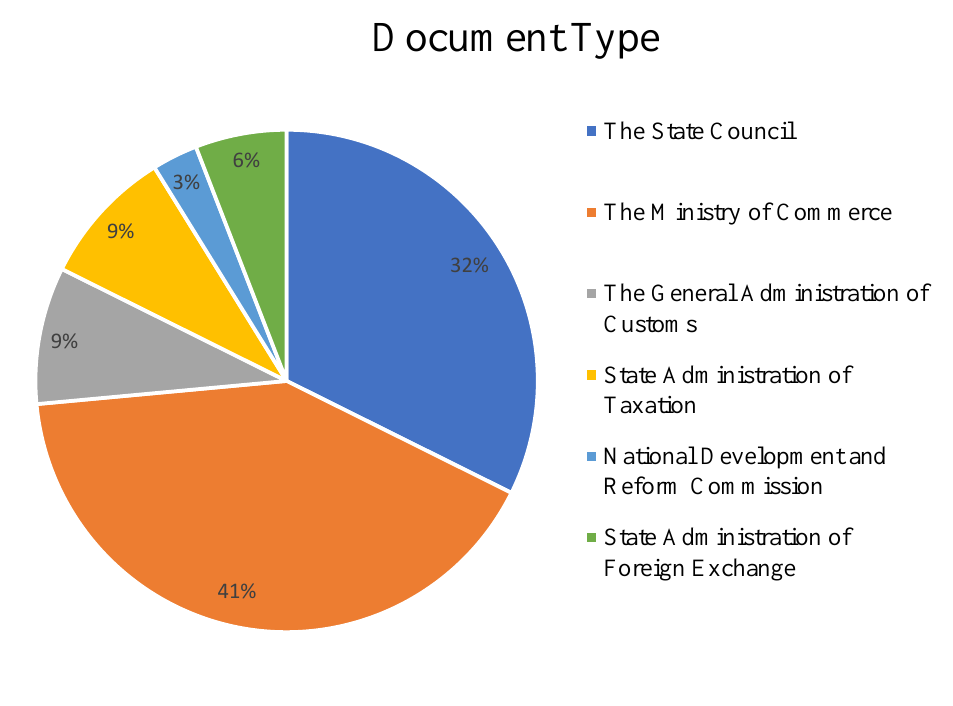
Figure 2. The categories of official documents.